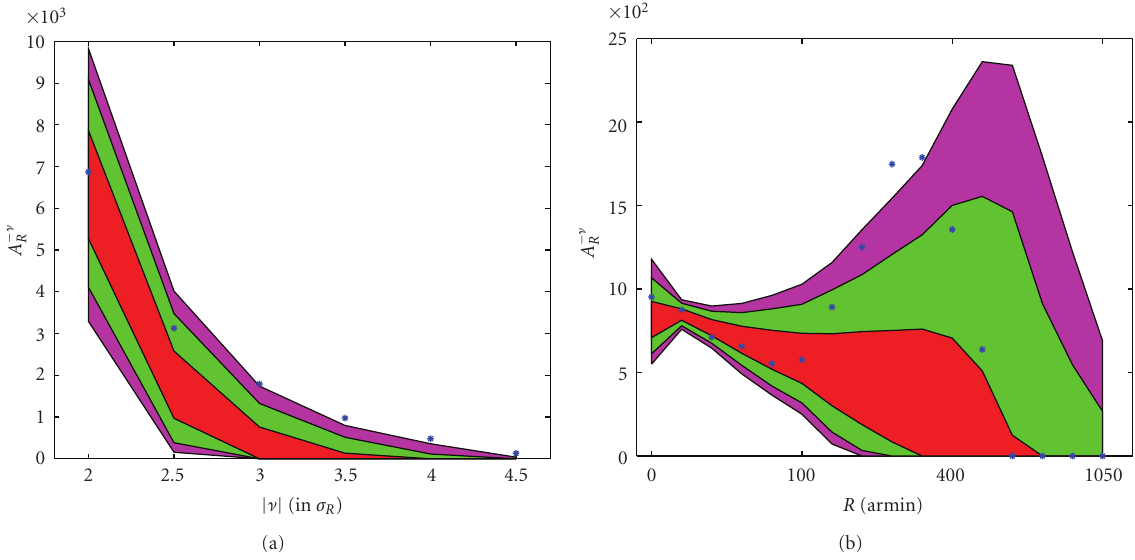
Figure 4: (a) cold area of the SMHW coe ffi cients (at R = 300 arcmin), as a function of the threshold ( ν ). (b) cold area ( A − ν coe ffi cients (at ν = 3 σ R ), as a function of the scale ( R ). As in Figure 2, the red, green, and magenta regions represent the 32%, 5%, and 1% acceptance intervals, respectively. These plots correspond to the analysis done by